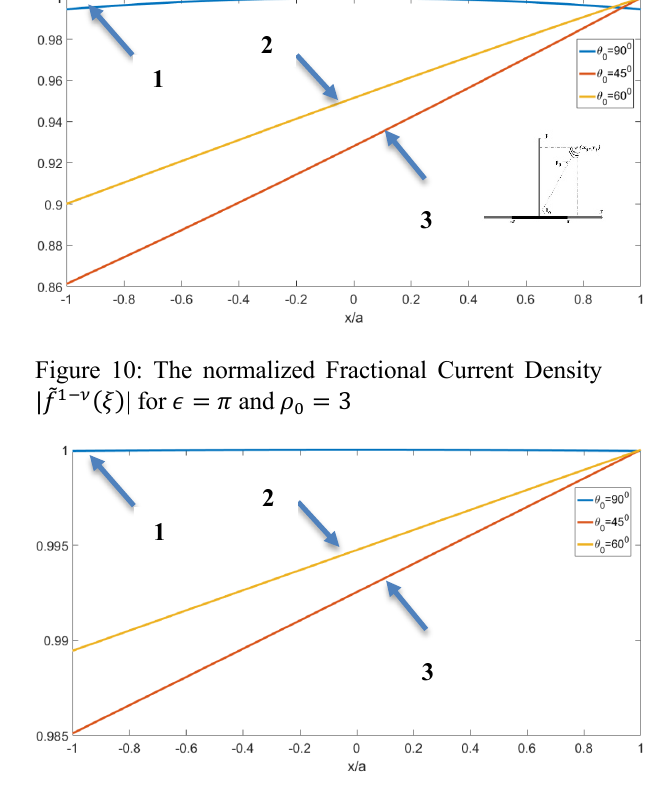
Figure 11: The normalized Fractional Current Density |𝑓y Y2$ (𝜉) | for 𝜖 = 𝜋 and 𝜌 = F